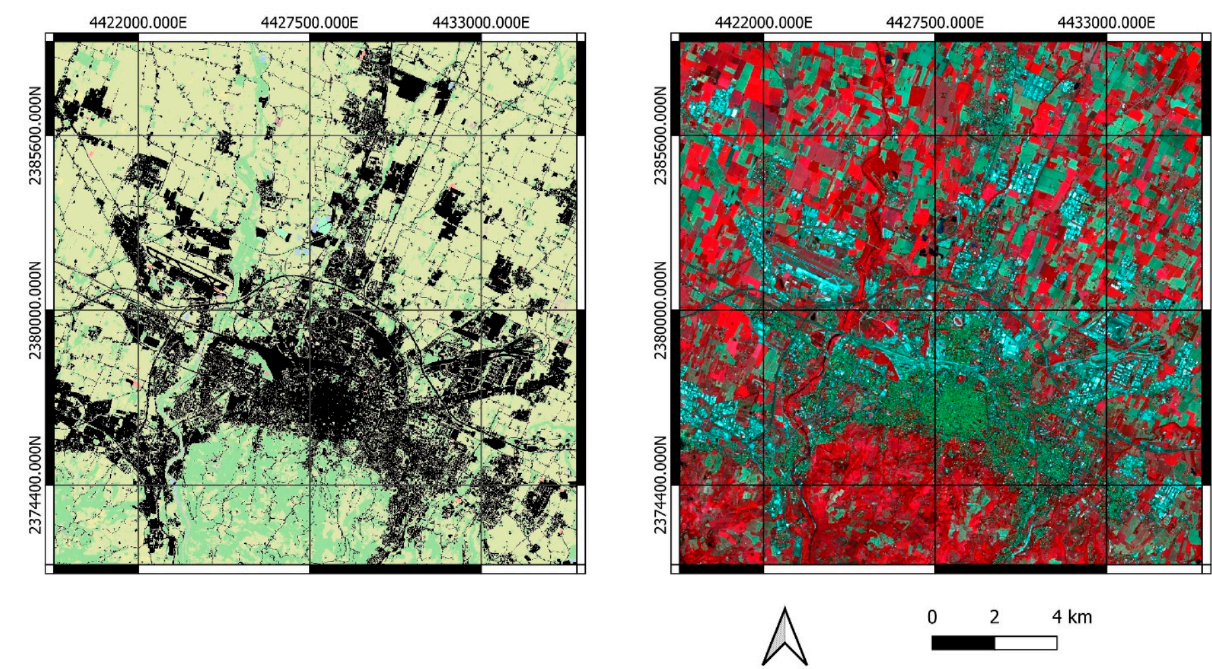
Figure 5. Artificial abiotic surfaces, in black ( on the left ), compared with a Sentinel-2 image ( on the right ).